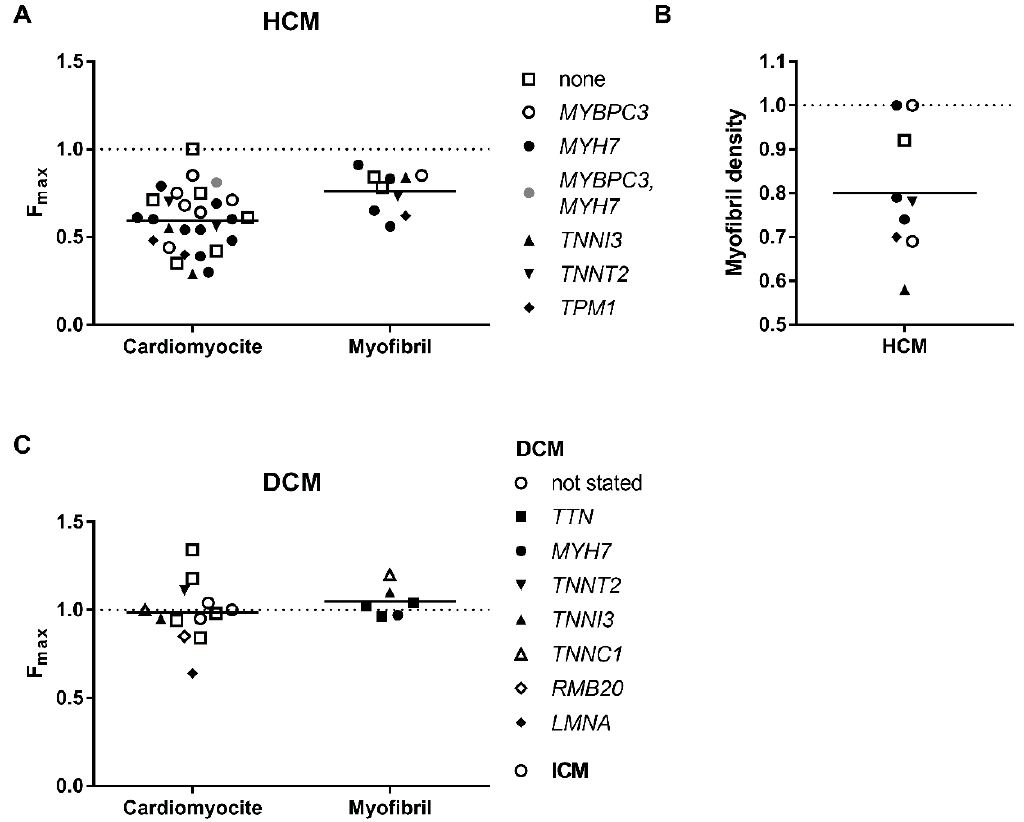
Figure 1. Maximum force of contraction by different types of preparations: from hearts of patients with HCM ( A ) and DCM ( C ). As can be seen, the maximal force generated by cardiomyocytes as well as myofibrils is lower in the HCM samples. The force is not diminished in DCM samples. ( B ) Density of myofibrils in cells were measured in some HCM samples. Each data point represents a different experimental group where the symbols indicate genes where mutations were found. See also Tables 1 and 2. All values are normalised to those of donor heart muscle (dashed line).